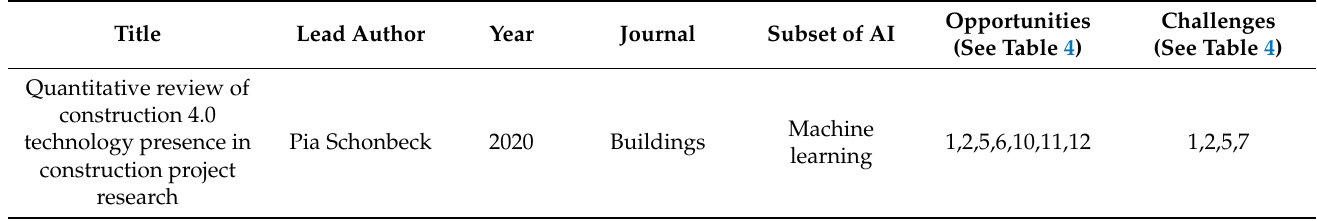
Table 7. Opportunities and challenges of adopting AI in the construction